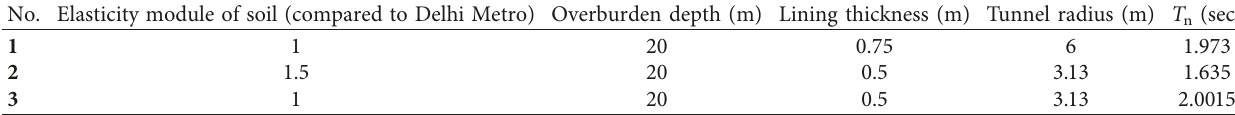
Figure 11: Mean and μ + σ for log of the spectral acceleration for models in the presence (SF) and absence (FF) of a tunnel at a distance of 51.33m from the center of the tunnel projection onto the ground surface. Table 6: Properties of models that presence of the tunnel amplifies the acceleration spectrum in the tunnel center image on the ground surface.